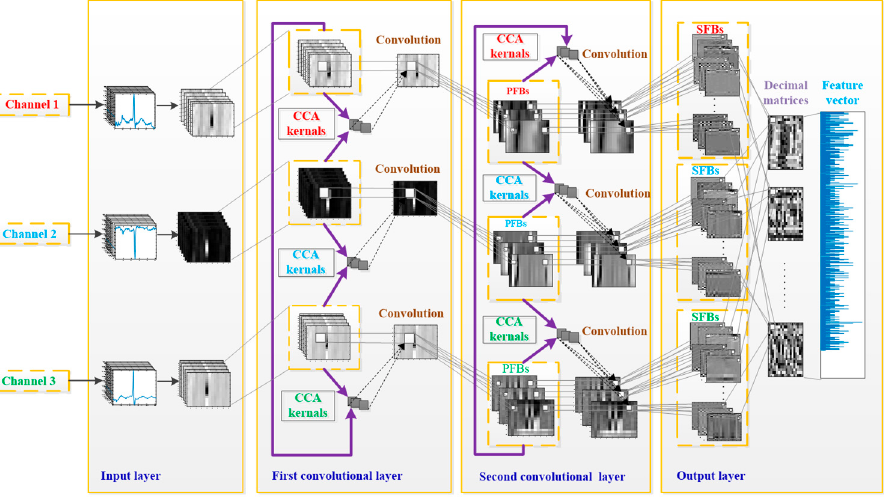
Figure 3. The structure of the TL-CCANet.